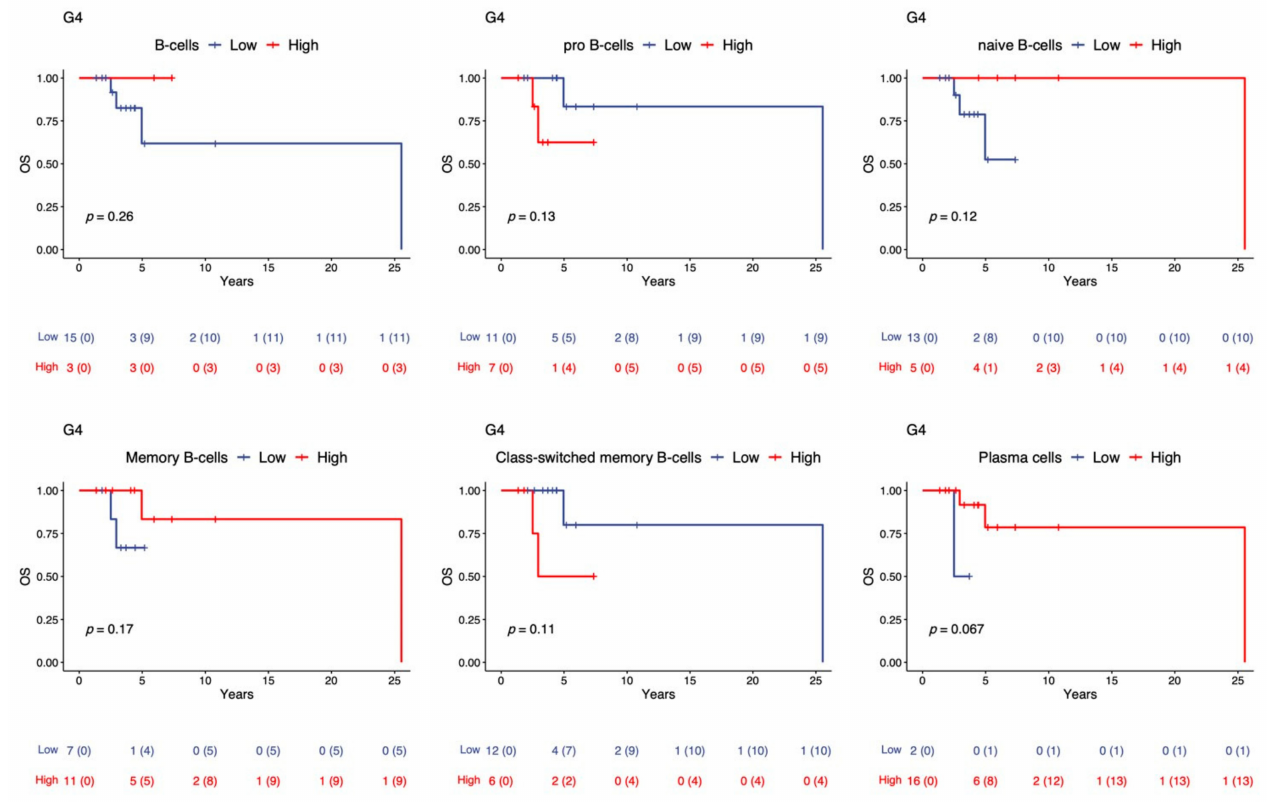
Figure 3. Kaplan–Meier overall survival curve of MB patients with high or low B cell expression. OS curves for patients according to the high and low expression levels of different B cell subsets, such as pro-B, naïve B, memory B class-switched memory B and plasma cells in G4 MB tumors.